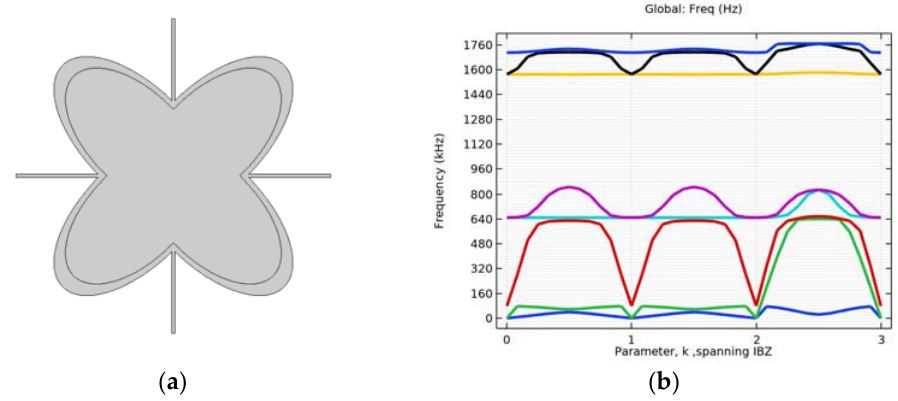
Figure 13. Response for inner ellipse 170 × 90, rod 3 mm. ( a ) microstructure, ( b ) responce for first eigenfrequenciew. One band gap exist, between 5th and 6th eigenfrequency (850–1570 Hz).